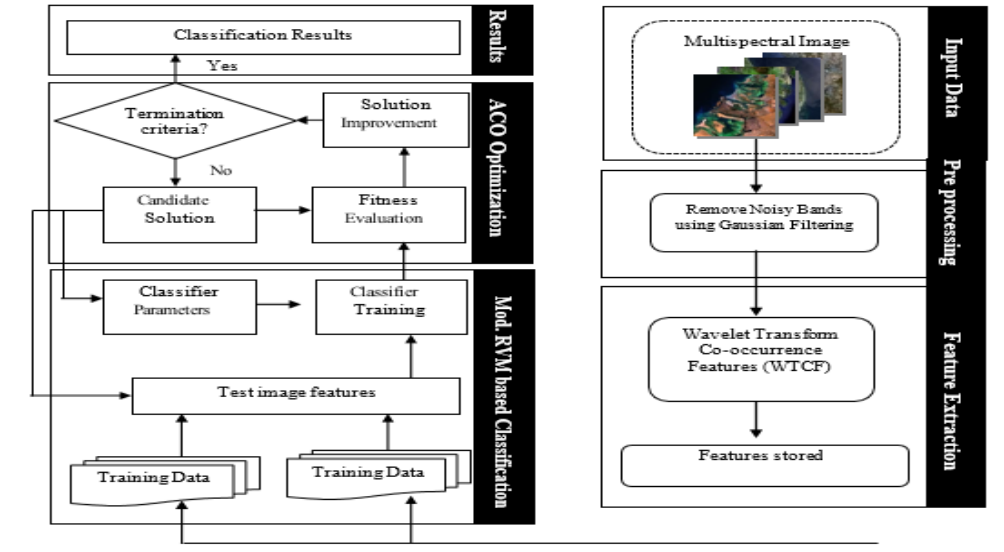
Figure 1. Flowchart of the Steps Involved in Proposed Optimized RVM Classification